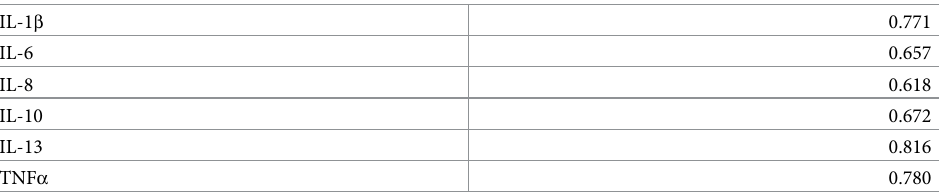
Table 3. Cytokine component loading